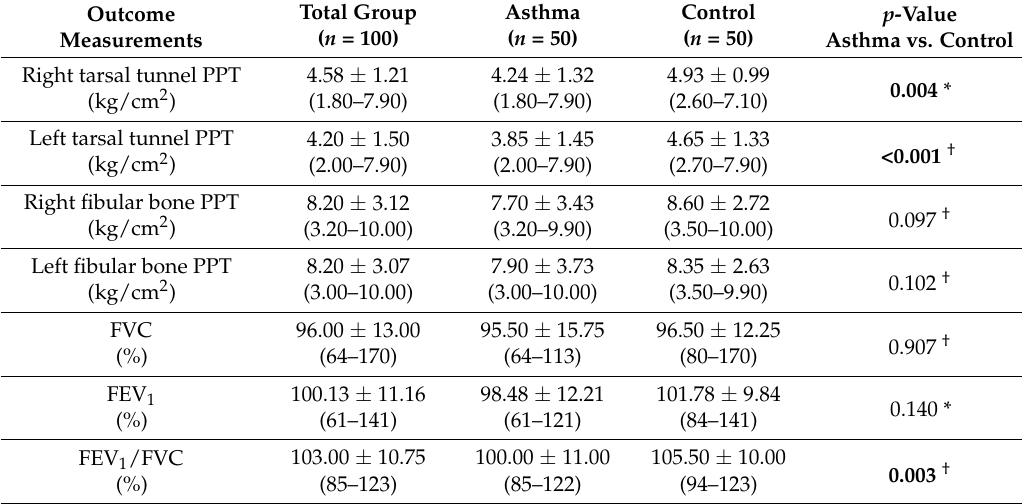
Table 3. Comparisons of outcome measurements between patients diagnosed with asthma and healthy matched-paired controls.